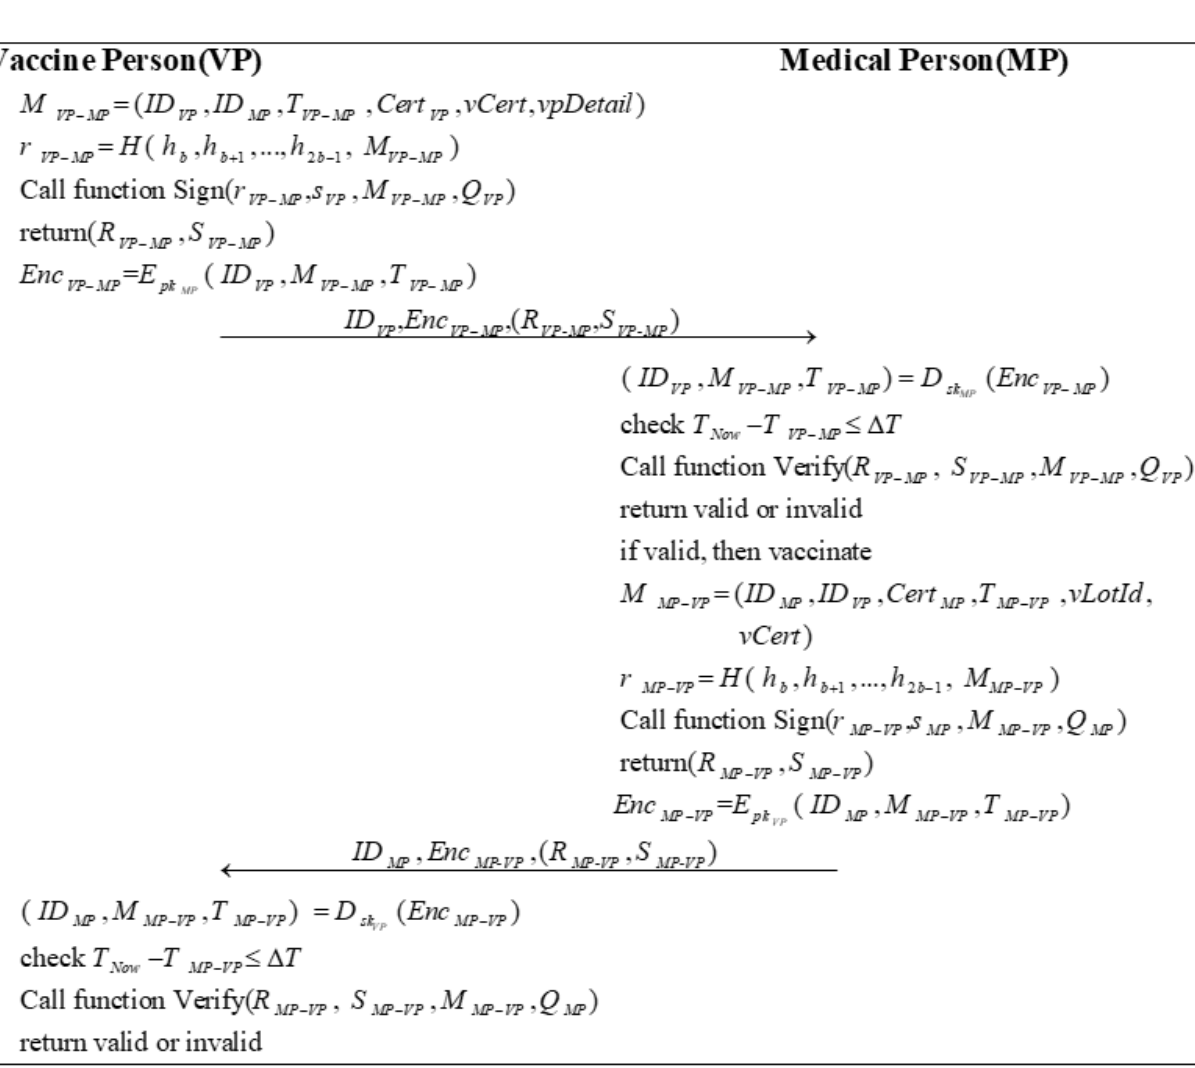
Figure 9. The process of vaccination.